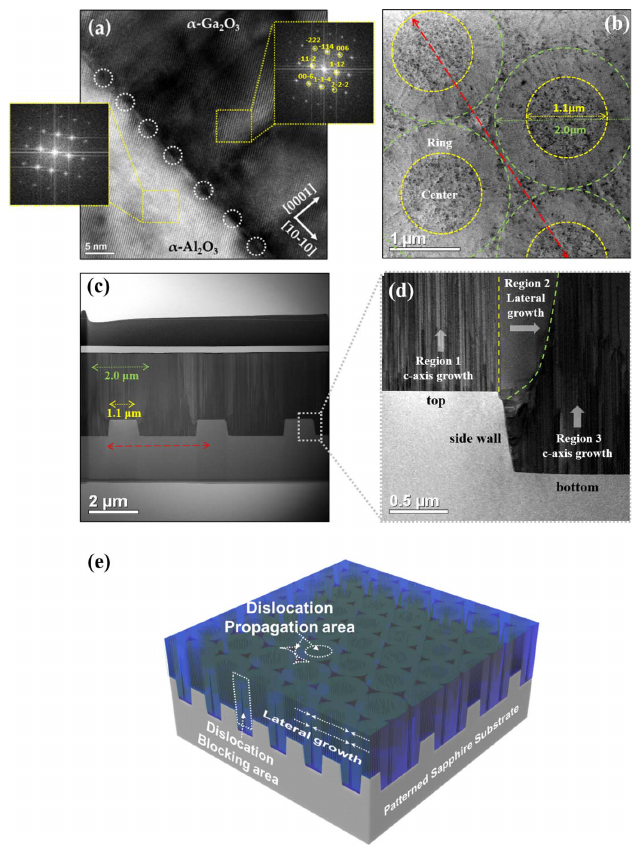
Figure 4 ( a ) High-magnification cross-sectional TEM image of the (cid:2) -Ga 2 O 3 epilayers/ (cid:2) -Al 2 O 3 interface viewed along [11–20] axis. Inset diffraction patterns of (cid:2) -Ga 2 O 3 epilayers grown on CF-PSS. ( b ) Plan-view, ( c )–( d ) low-magnification cross-sectional TEM image. ( e ) Schematic of the behavior of TD in the (cid:2) -Ga 2 O 3 epilayer grown on